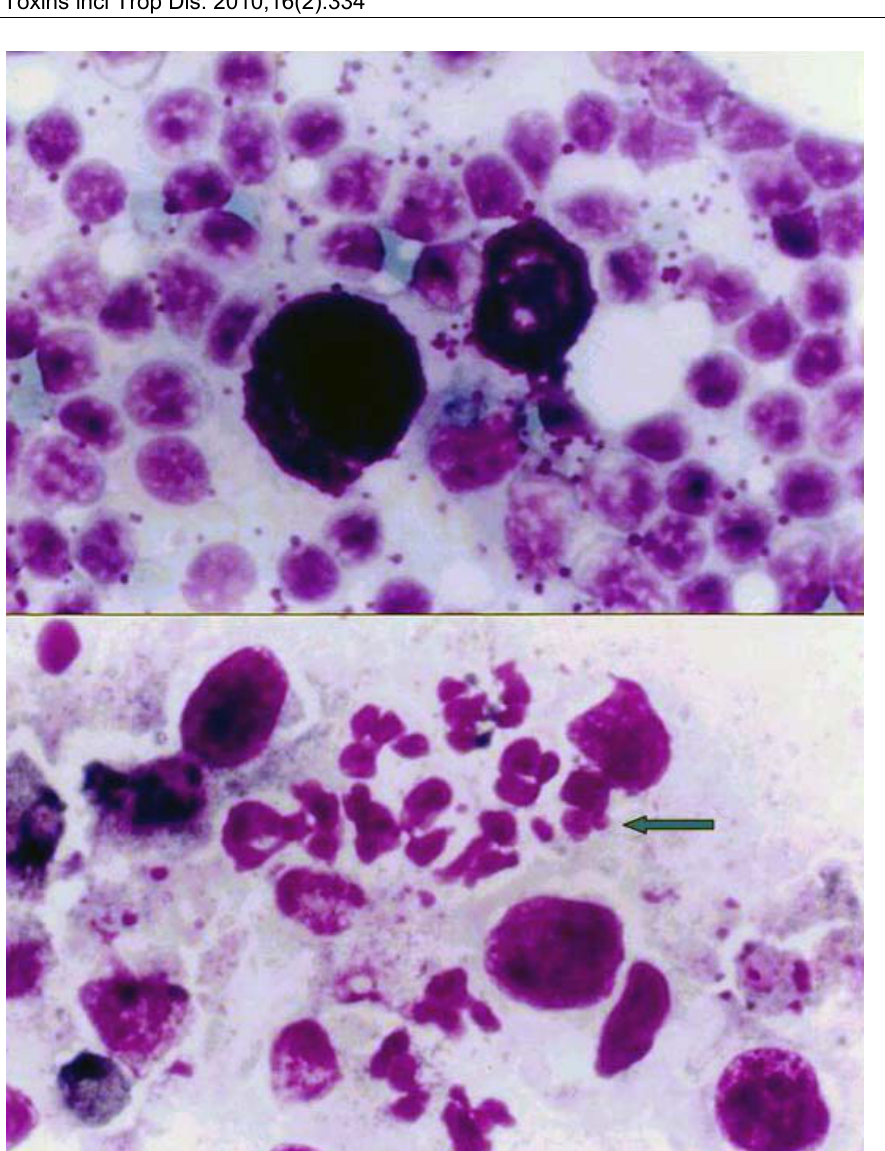
Figure 7. Light micrograph of infiltrated tumor cells in lymph nodes after dorsal implantation of B16F10 melanoma cells followed by Curcuma zedoaria crude extract